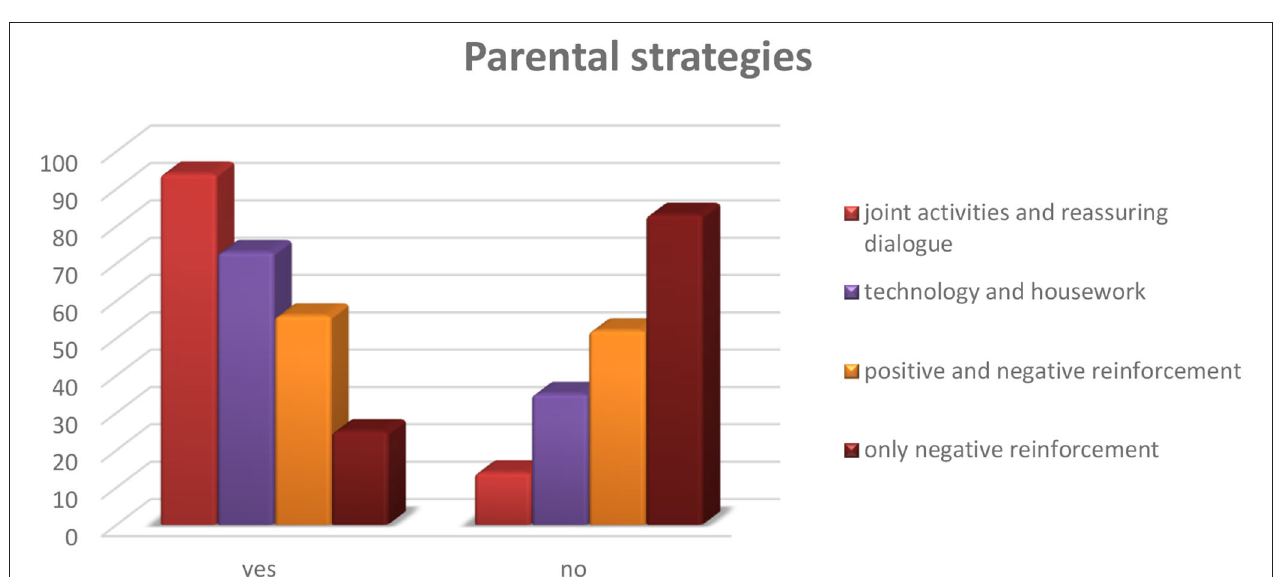
Frontiers in Neurology |